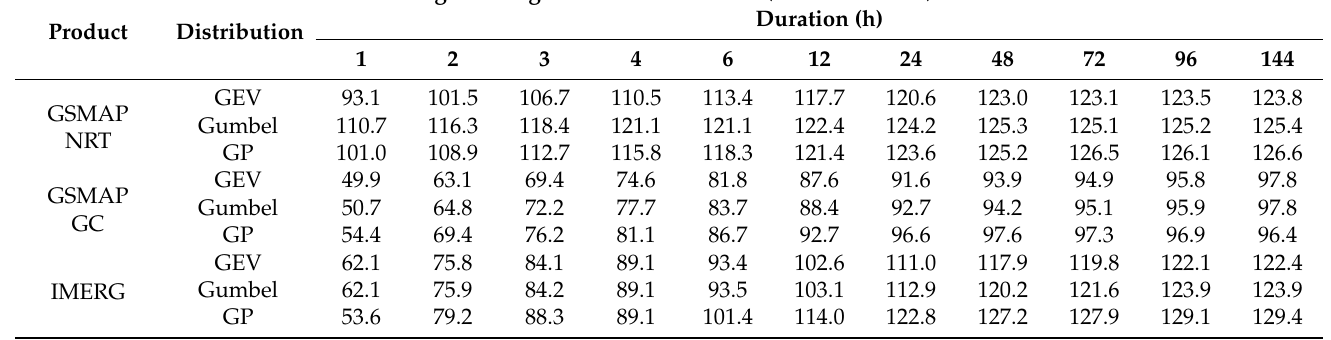
Table 6. Negative Log-likelihood values of different distributions at Baghdad for GSMaP NRT, GSMaP GC, and